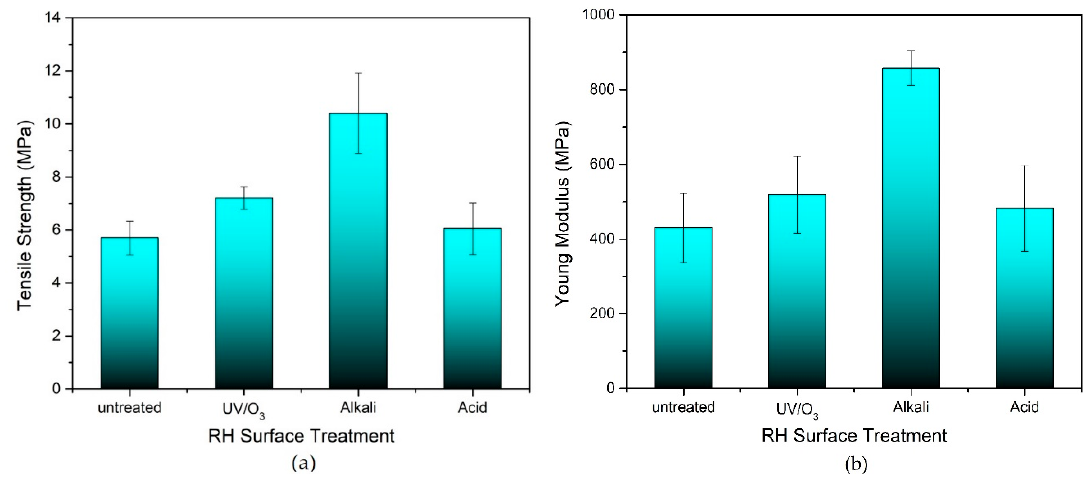
Figure 3. ( a ) Tensile strength and ( b ) Young’s modulus of untreated, alkali- and UV-treated RH with 50 wt.%